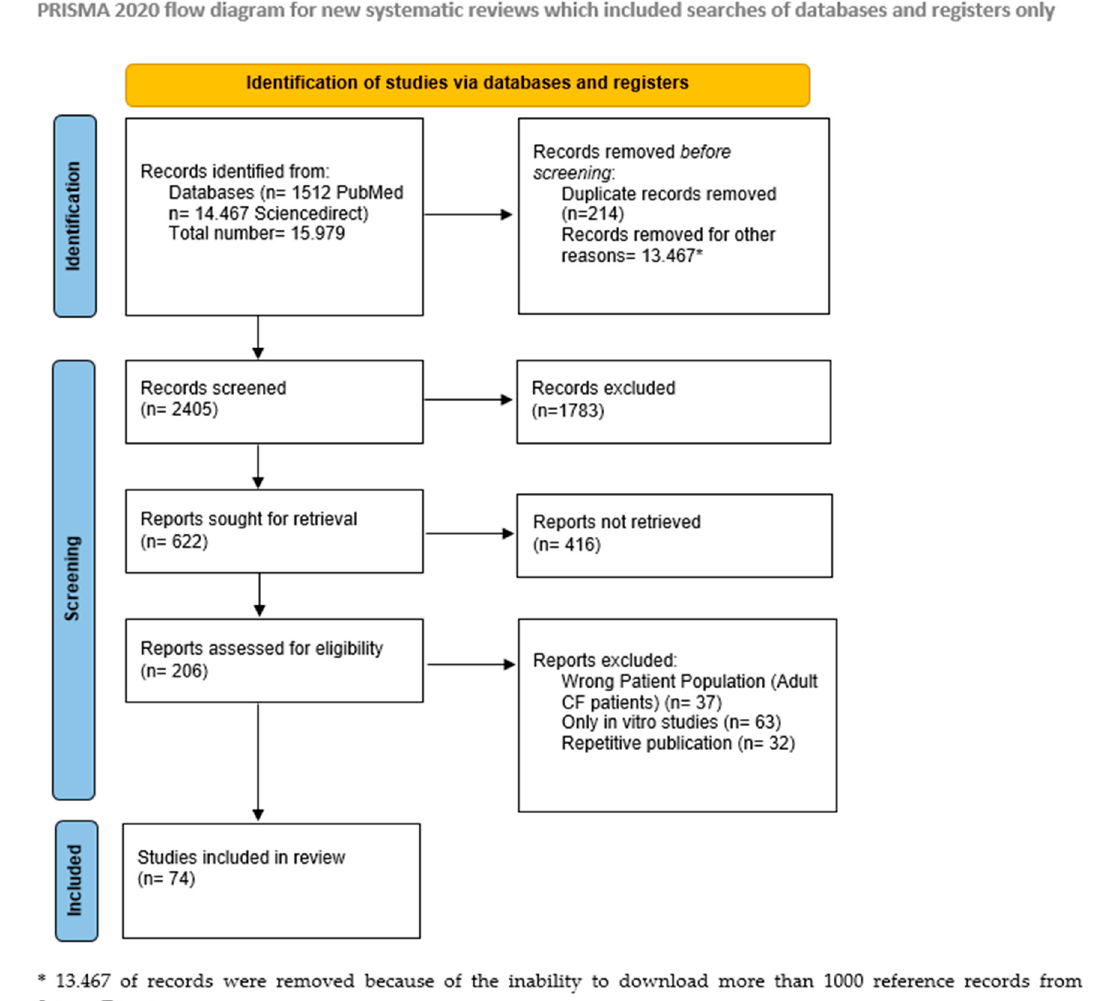
Figure 1. PRISMA flowchart of the literature screening. Antibiotic treatment in CF patients.